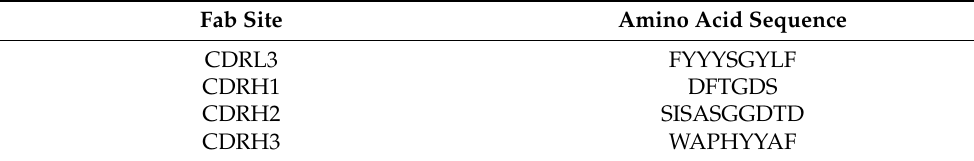
Table 2. DFab1 Φ variable